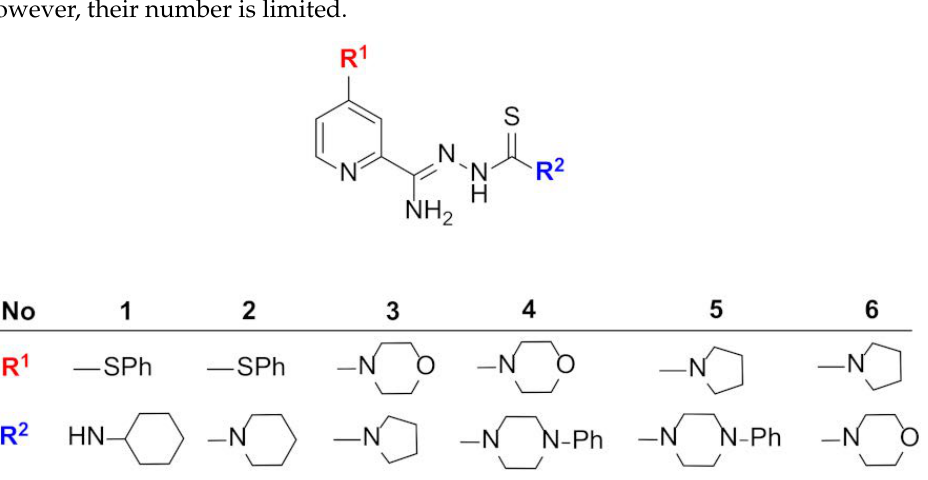
Figure 2. Structural formulas of the studied